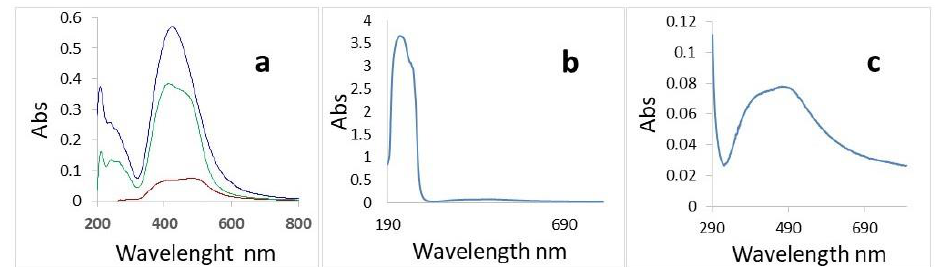
Figure 2. UV study of the used materials. ( a ) Samples from the stock solution from commercially obtained AgNPs.: 0.50 mg mL −1 , 0.33 mg/mL, and 0.20 mg mL −1 in distilled water; ( b ) Absorption of